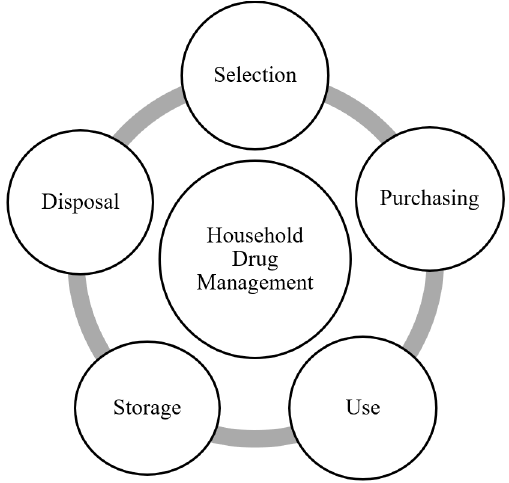
Figure 1. Household Drug